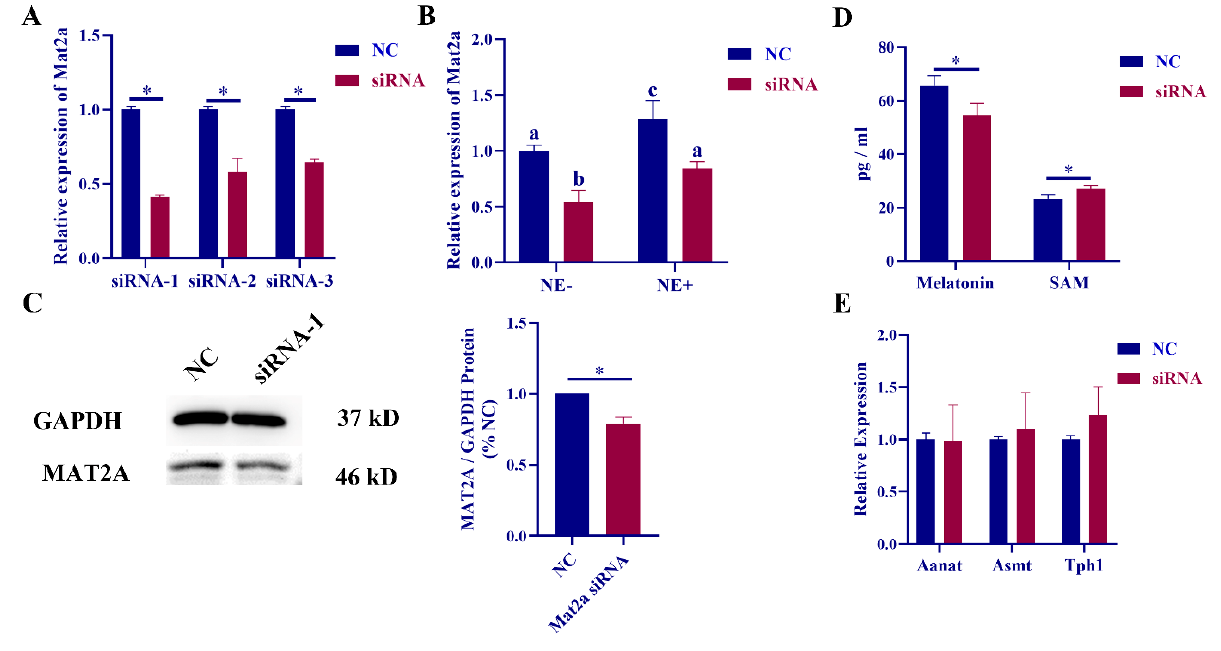
Figure 2. Interference with mat2a expression inhibits melatonin synthesis. ( A ) Relative expression of mat2a mRNA in rat pineal cells transfected with mat2a siRNA. ( B ) Relative expression of mat2a mRNA after co-treatment with NE and mat2a siRNA-1. The letters (a, b, c) mean there are significant differences among them. ( C ) Relative expression of MAT2A protein expression after mat2a siRNA-1 transfection. ( D ) Relative expression of melatonin and S-adenosine methionine (SAM) content in pineal cell supernatant after transfection with mat2a siRNA-1. ( E ) Relative mRNA expression of melatonin synthesis-related genes after mat2a siRNA-1 transfection. *, p < 0.05. NC means Mat2a siRNA-NC.